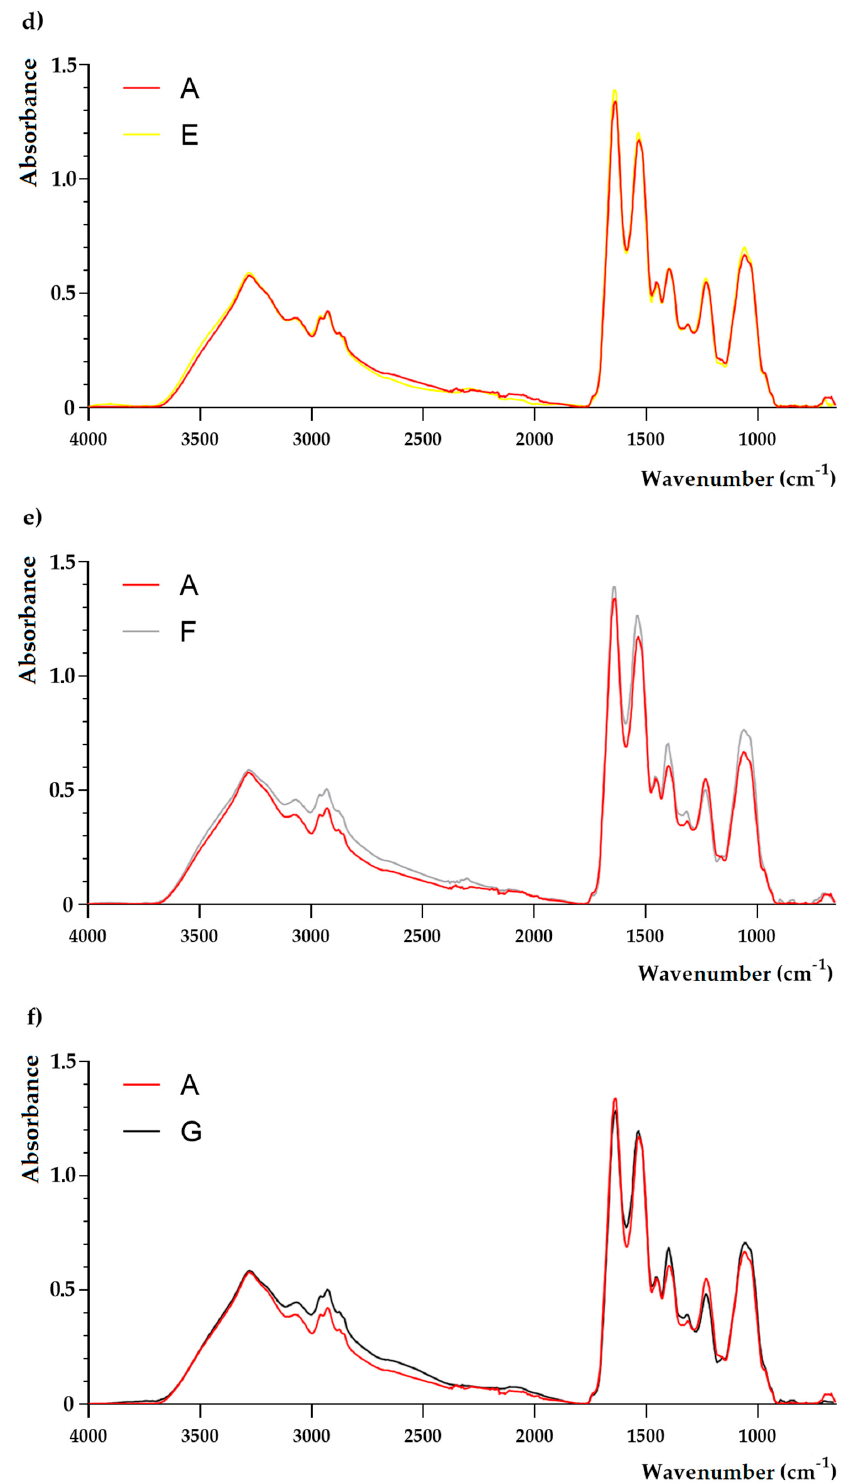
Figure 3. FTIR spectra of Staphylococcus aureus ATCC 43300 (MRSA) strain grown in Mueller-Hinton broth containing: no chemicals (control—medium A), Tween 80 (medium B), DMSO (medium C), Tween 80 and DMSO (medium D), lavender essential oil (LEO) at subinhibitory concentration (MIC 50 ) (medium E), octenidine dihydrochloride (OCT) at subinhibitory concentration (MIC 50 ) (medium F), LEO / OCT at subinhibitory concentrations (MICc 50 ) (medium